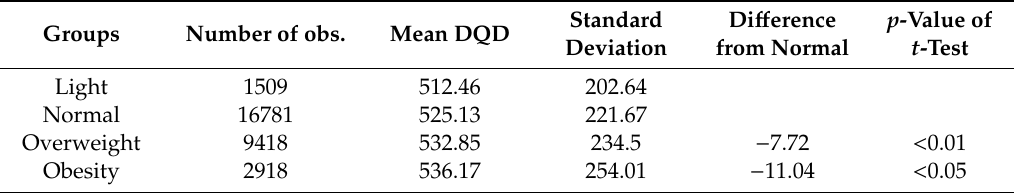
Table 5. The relationships between DQD and body mass index